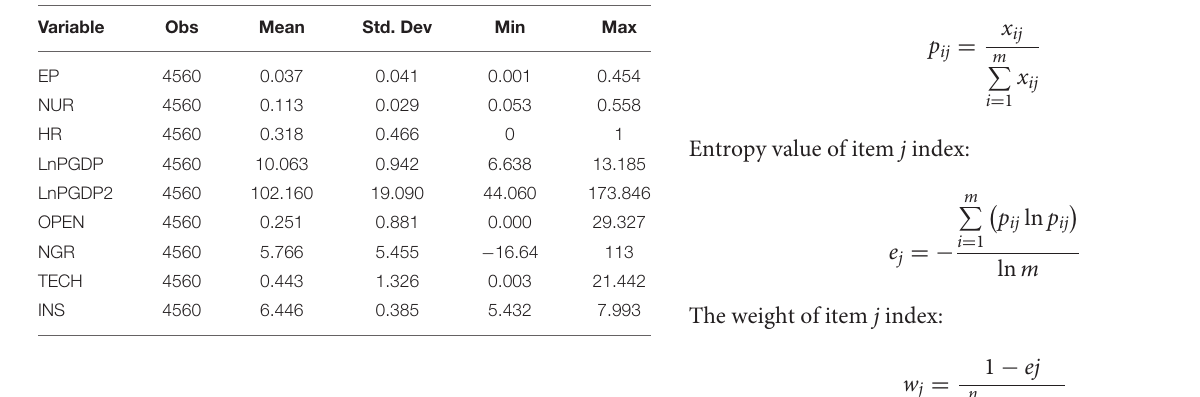
TABLE 2 | Descriptive